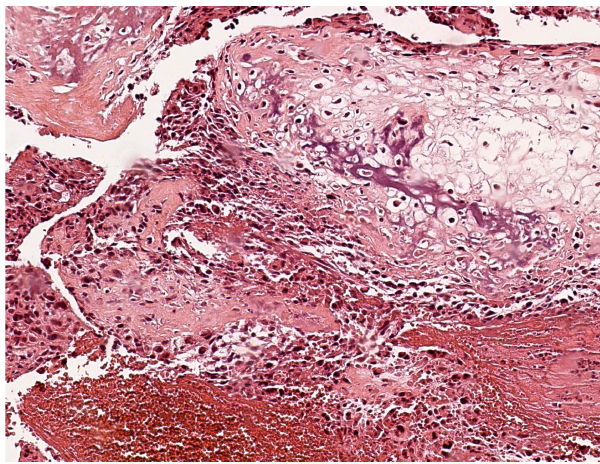
Figure 2 - Photomicrograph showing the telangiectasia type of osteosarcoma (non-osteoblastic) (200 X- HE) Table 1 - Distribution of select anatomopathological variables for the 24 patients with primary osteosarcoma that was non- metastatic at diagnosis Variable